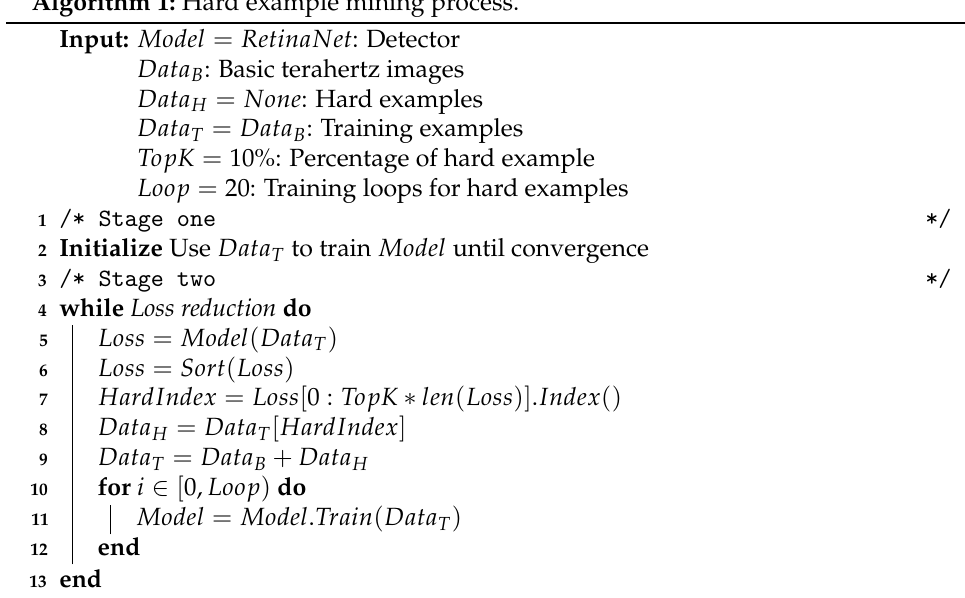
Algorithm 1: Hard example mining